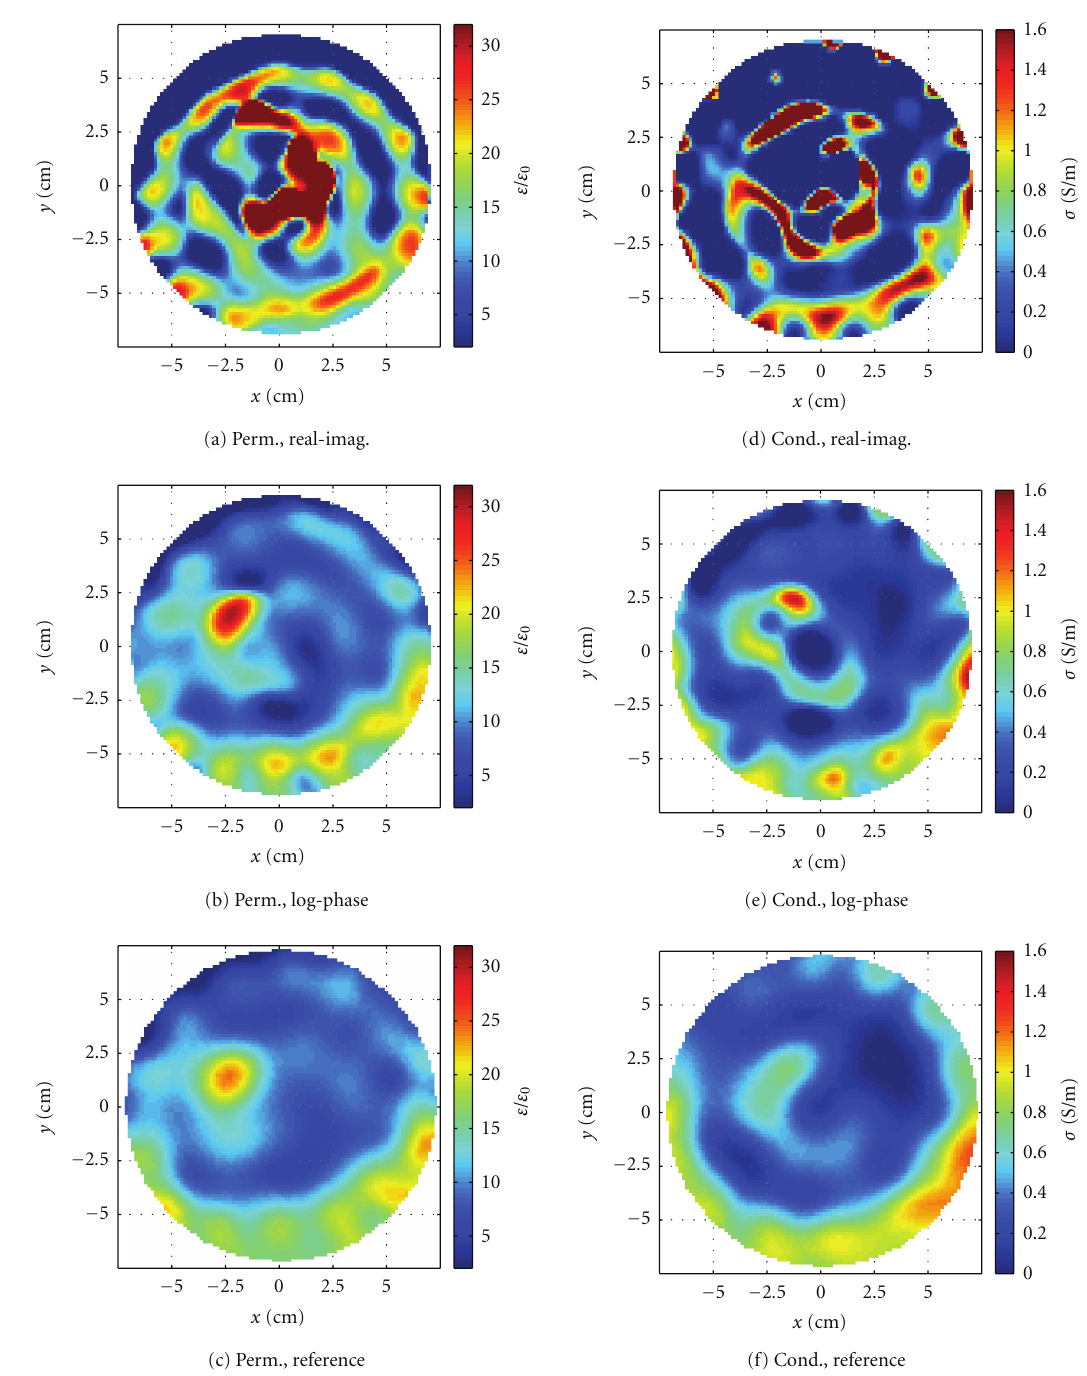
Figure 5: Reconstructions of a patient measurement. The results obtained using the CSI algorithm with the real-imaginary formulation are shown in (a) and (b), and the results obtained with the log-phase formulation are shown in (c) and (d). The results obtained using the Gauss-Newton algorithm described in [22] are shown in (e) and